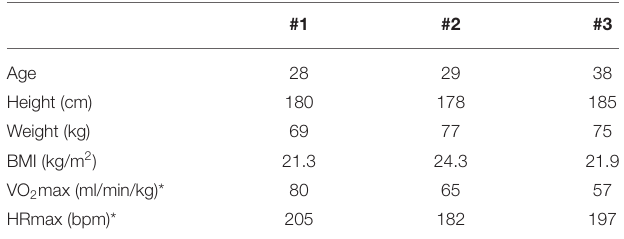
TABLE 1 | Athlete